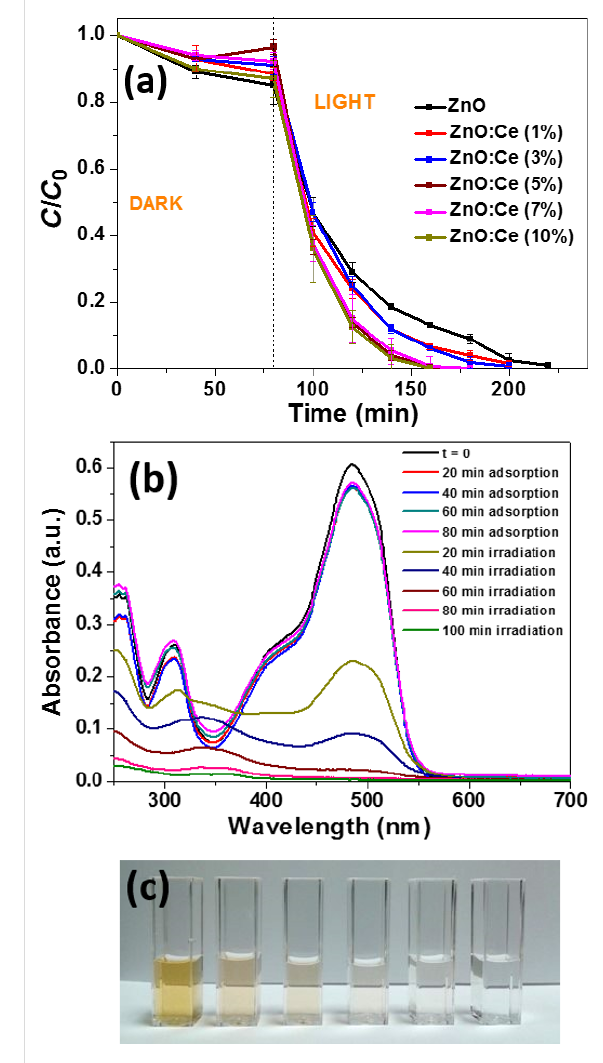
macropores. The 5% Ce-doped rods exhibit a higher surface area than ZnO rods (21.7 ± 0.2 m 2 /g and 39.9 ± 0.3 m 2 /g for